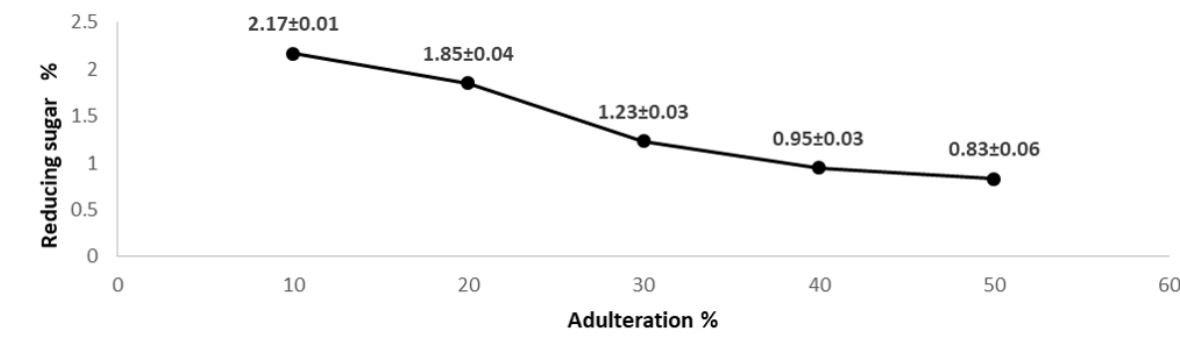
Figure 1: Reducing sugar content of adulterated jaggery samples with sugar.